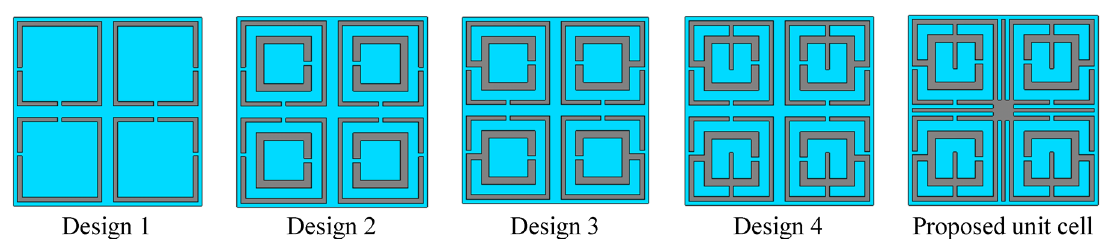
Figure 3. Different evolution steps towards the proposed unit cell (CST STUDIO SUITE 2019, https:// www. 3ds. com/ produ cts- servi ces/ simul ia/ produ cts/ cst- studio- suite) 42 .